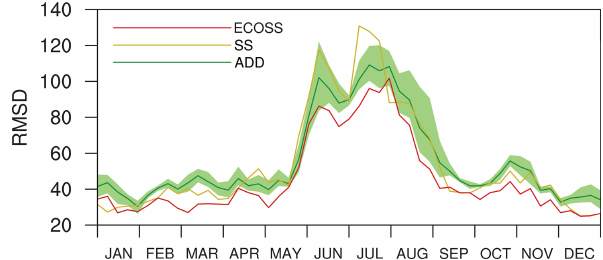
Figure 7. The same as Fig. 4 except for the ADD (dark green solid line), SS (yellow solid line), and ECOSS (red solid line) experi- ments. The green shaded band denotes the minimum and maximum RMSD across three random addition